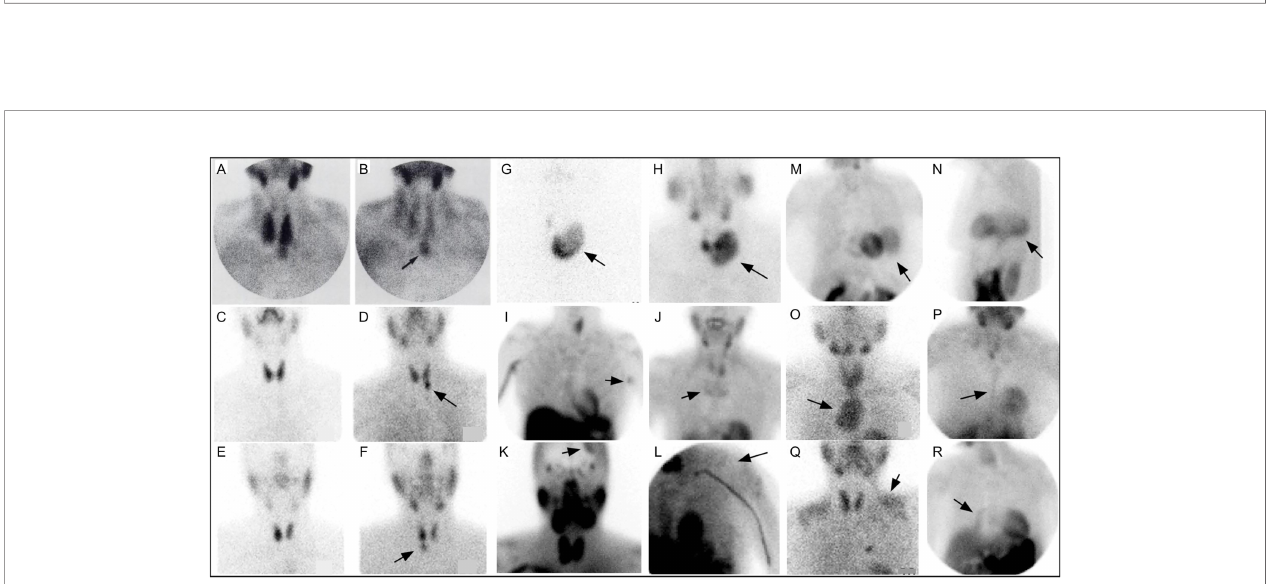
FIGURE 4 | Early 99m Tc-sestamibi parathyroid imaging (A) with uniform uptake within the thyroid and more mild focal uptake in the left lower neck, inferior to the thyroid. (B) Delayed image shows decreased radiotracer uptake within the thyroid and increased radiotracer uptake within a 2.5g parathyroid adenoma (arrow). Example of dual tracer method (C – F) with left image depicting 99mTc-pertechnetate and right image depicting 99mTc-sestamibi showing a left PA (D) and right PA (F) . Uptake not related to PA (arrows) can also be seen (G – R) . Multinodular goiter 99mTc-pertechnetate (G) and 99mTc-sestamibi (H) . Also depicted on 99mTc- sestamibi are (I) left axillary skin fold, (J) manubrium brown tumor, (K) meningioma, (L) deltoid implant, (M) diaphragmatic hernia anterior and (N) lateral, (O) retropharyngeal PA and goiter extending into mediastinum, (P) sternotomy, (Q) muscle uptake, (R) atelectasis adjacent to mediastinum on the right. Reproduced with permission from: Taillefer R, Boucher Y, Potvin C, Lambert R. Detection and localization of parathyroid adenomas in patients with hyperparathyroidism using a single radionuclide imaging procedure with technetium-99m-sestamibi (double-phase study). J Nucl Med. 1992 Oct;33(10):1801-7. PMID: 1328564 .